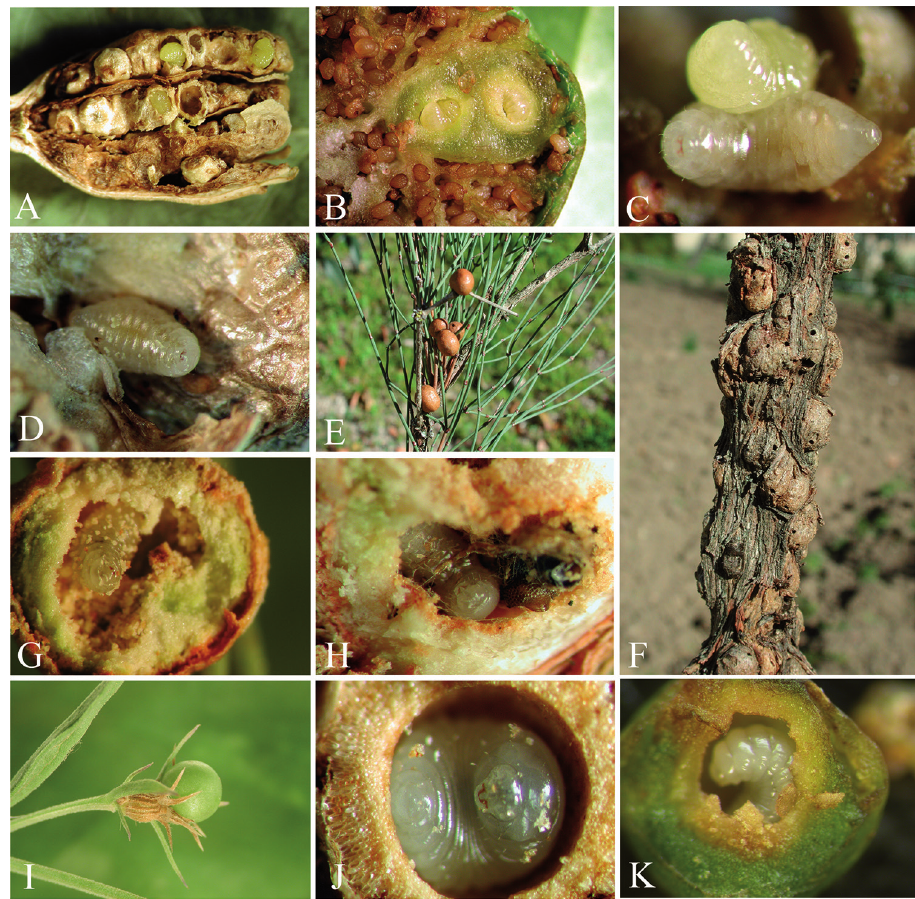
Figure 12. A Galls of Aylax minor on Papaver spp. B detail of cells of Aylax minor on Papaver spp . C larvae of Ormyrus capsalis on of non-parasitized larvae of A. minor D Detail of solitarious larvae of O. capsalis inside gall cell of A. minor E galls of Eurytoma gallephedrae on Ephedra nebrodensis F galls of Eury- toma flaveola on Ephedra nebrodensis G larvae of Ormyrus cupreus inside the gall cell H larvae of Ormyrus cupreus inside the gall cell with debris of adult specimen of the same species I gall of Liposthenes kerneri on Nepeta hispanica J ventral view of larvae of O. diffinis inside the gall cell K lateral view of larvae of O. diffinis inside the gall